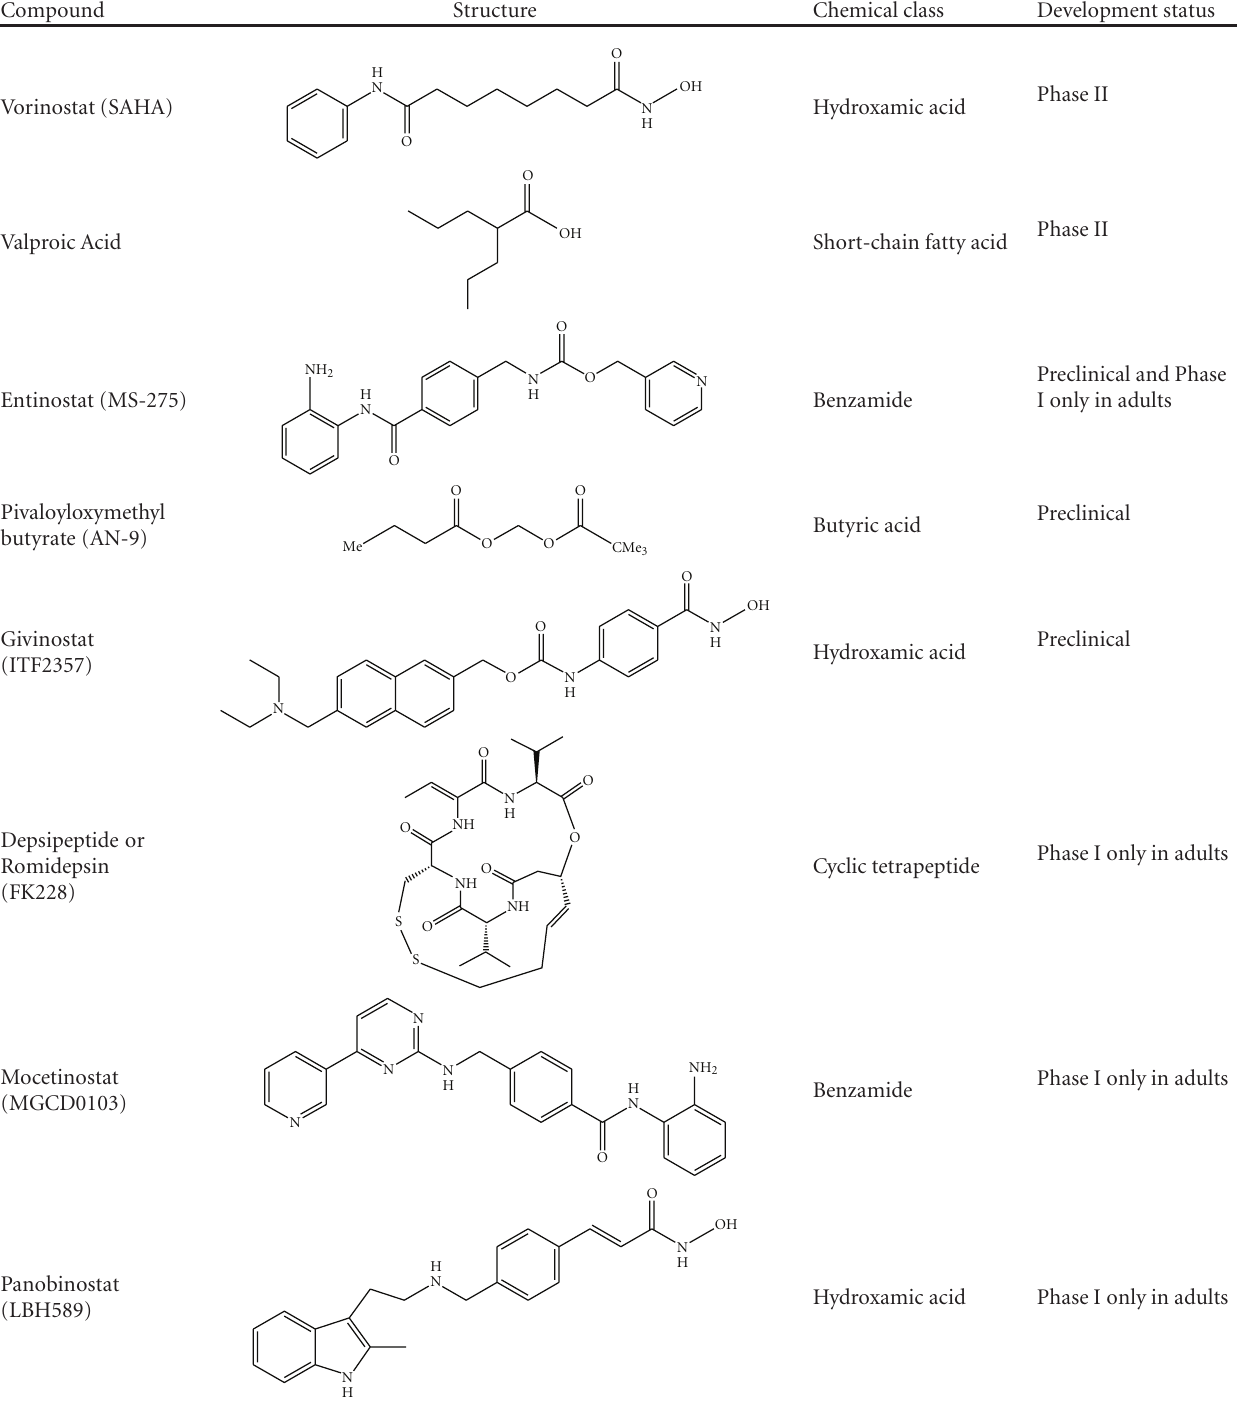
Table 1: Main HDIs evaluated as emerging drugs for acute leukemias in pediatric and adult